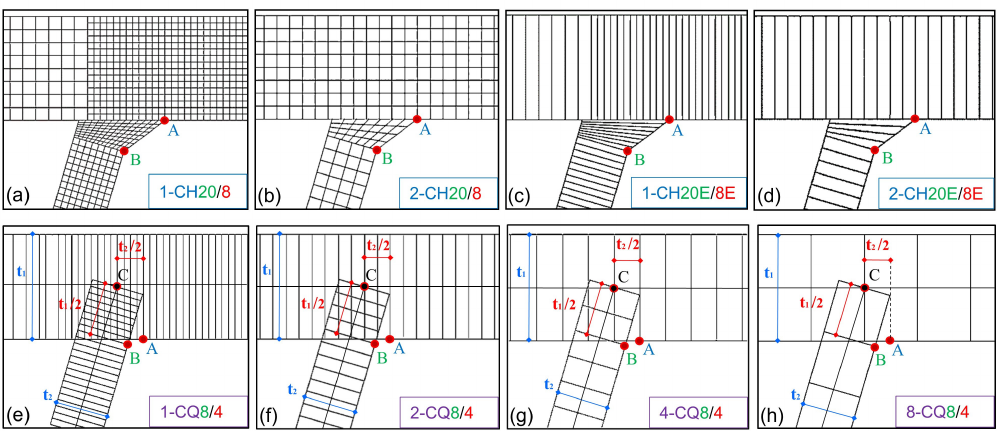
Figure 6. ( a – h ) Di ff erent meshing techniques used for the evaluation of SHSS